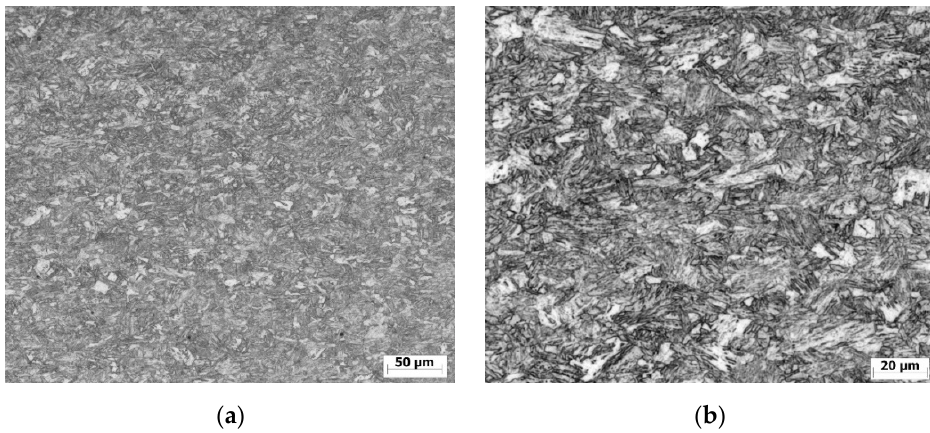
Figure 1. Microstructure of investigated steel S960MC: ( a ) magnification 200×; ( b ) magnification 500×.